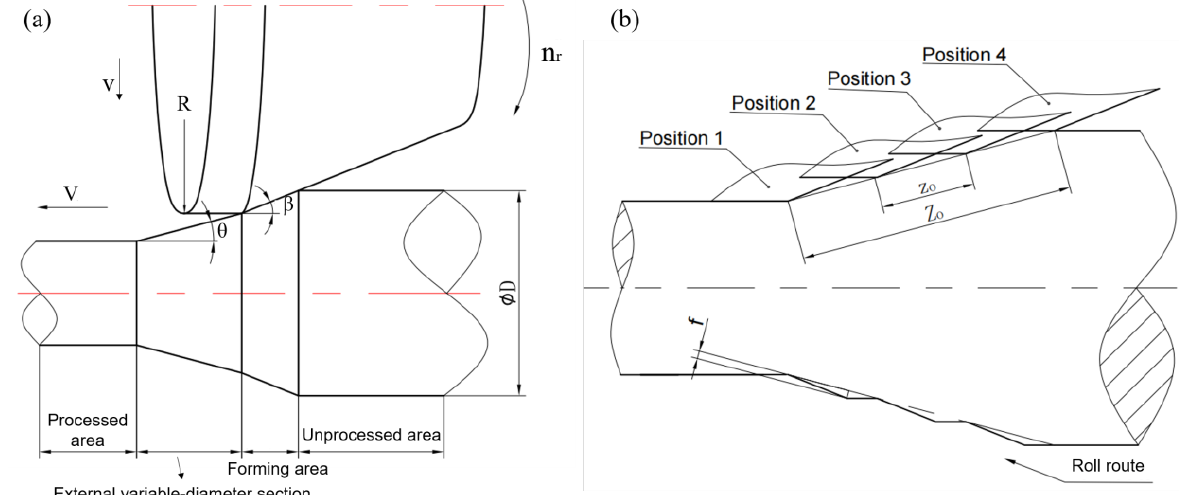
Figure 6. The external variable-diameter section ( a ) forming stage and ( b ) lead analysis of processing path.